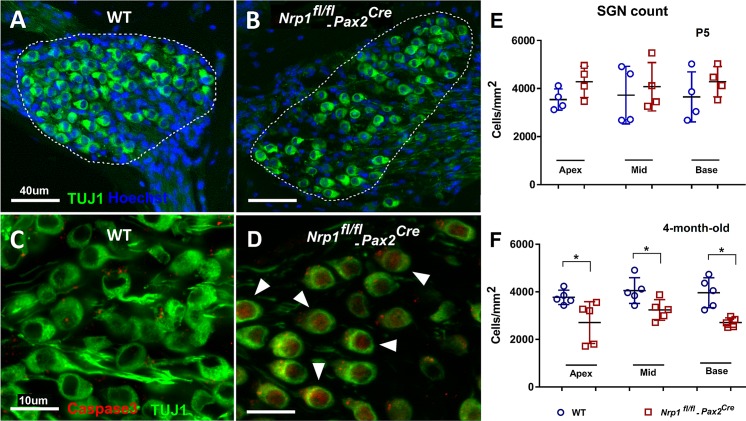
SGN density and caspase-3 expression in 4-month-old WT and Nrp1fl/fl;Pax2Cre mutant mice.Mid-modiolar sections of the cochlea (basal turn) showing lower density of the SGNs in 4-month-old Nrp1fl/fl;Pax2Cre mice compared to WT controls (A, B). Cochlear SGN of 4-month-old WT and Nrp1fl/fl;Pax2Cre mice were immunostained with antibodies to Caspase-3 (Red) to ascertain the fate of the SGN at cochlear maturity (C, D). Caspase-3 positive SGNs pointed by arrows in panel D (red staining) showing apoptosis of neurons in 4-month-old Nrp1fl/fl;Pax2Cre mice compared to WT controls on panel C. (E) There was no statistically significant difference between SGNs count of the Nrp1fl/fl;Pax2Cre mice at P5 when compared to WT controls (n = 4 per group). SGNs count at the apical, middle, and basal (n = 5 per group) turns of the cochlea was consistently lower in the 4-month-old Nrp1fl/fl;Pax2Cre mutant group compared to WT controls (F). *p<0.05. Scale bar = 40 μm for A, and B. Scale bar = 10 μm for C, and D.